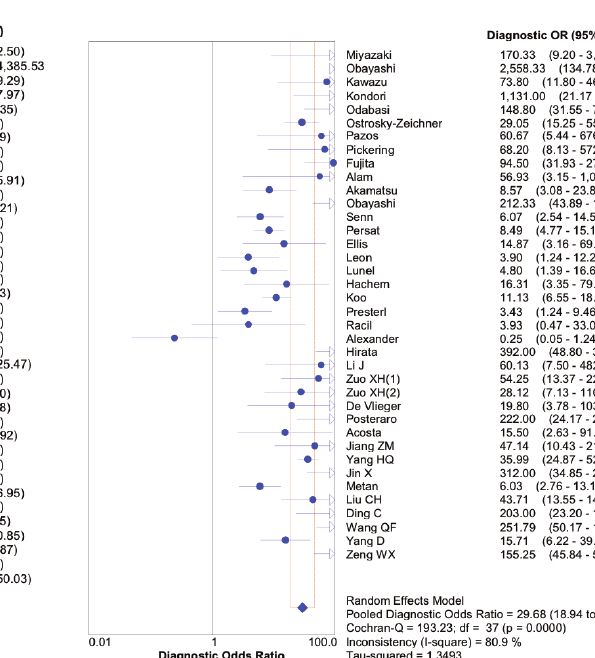
Figure 6: Pooled forest plot of -lr for 1,3-β-D-glucan in diagnosis of invasive fungal infection